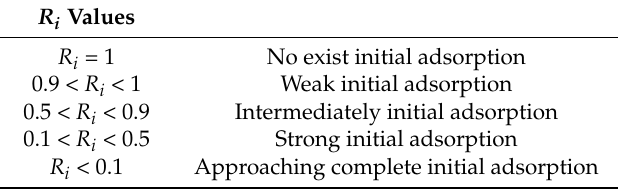
Table 4. Initial adsorption factor means from intraparticle diffusion kinetic model fitted kinetic